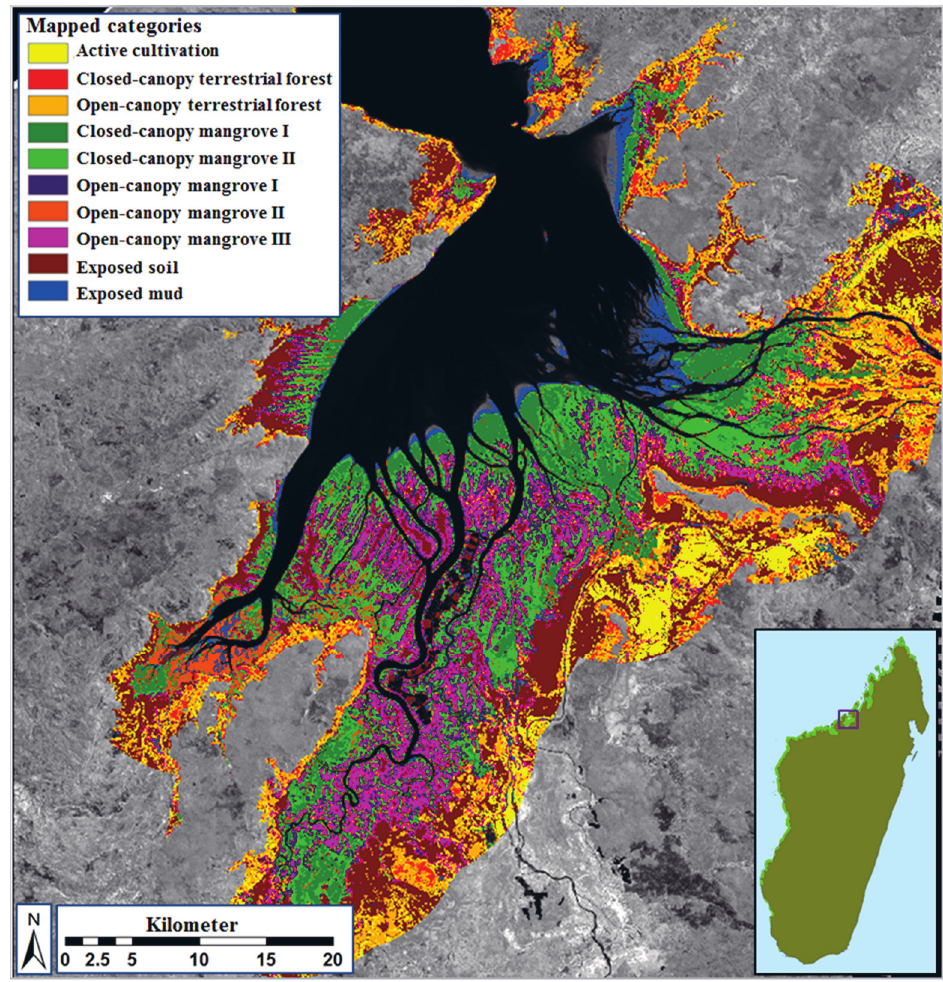
Figure 6. Classification results within the AOI, indicating 45,107 ha of mangroves distributed across five classes. The background image is Landsat 5 TM band